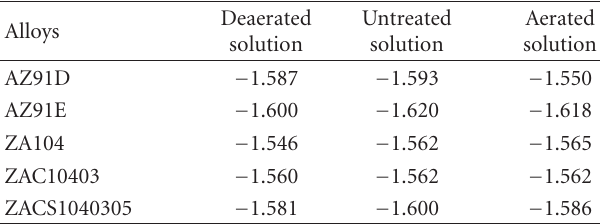
Table 2: Average E corr values (V) for AZ and ZA magnesium alloys after 8 h of immersion in deaerated, untreated and aerated 5% NaCl solutions saturated with Mg(OH) 2 at pH 9 and 25 ◦ C. (Standard deviation <